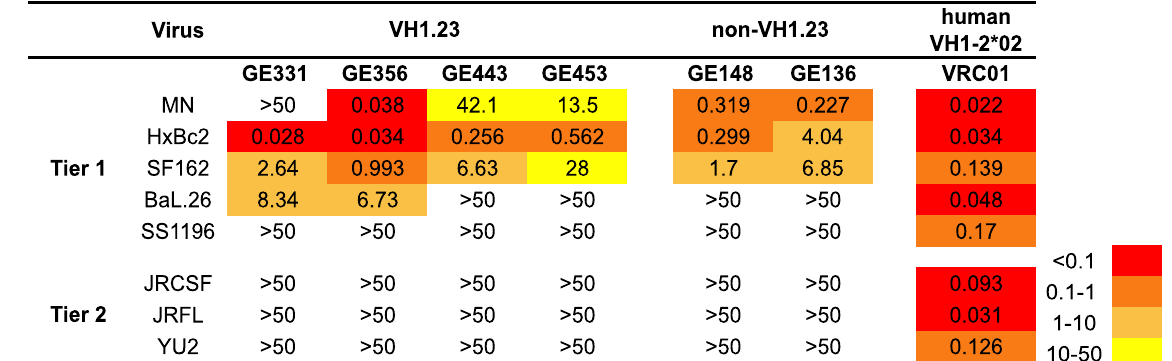
Figure 3. Neutralizing properties of vaccine-elicited CD4bs-directed MAbs. (A) Neutralization activity of four isolated VH1.23-using MAbs from the current study, two previously described non-VH1.23-using NHP MAbs against the CD4bs, and VRC01 were tested against a panel of viruses using the TZM-bl pseudovirus assay. The results are shown as neutralization IC 50 values, that is, the MAb concentration inhibiting 50% of viral entry. The IC 50 values are color-coded where red indicates ( , 0.1 m g/ml), dark orange (0.1–1 m g/ml), light orange (1–10 m g/ml), yellow (10–50 m g/ml) and white ( . 50 m g/ml).